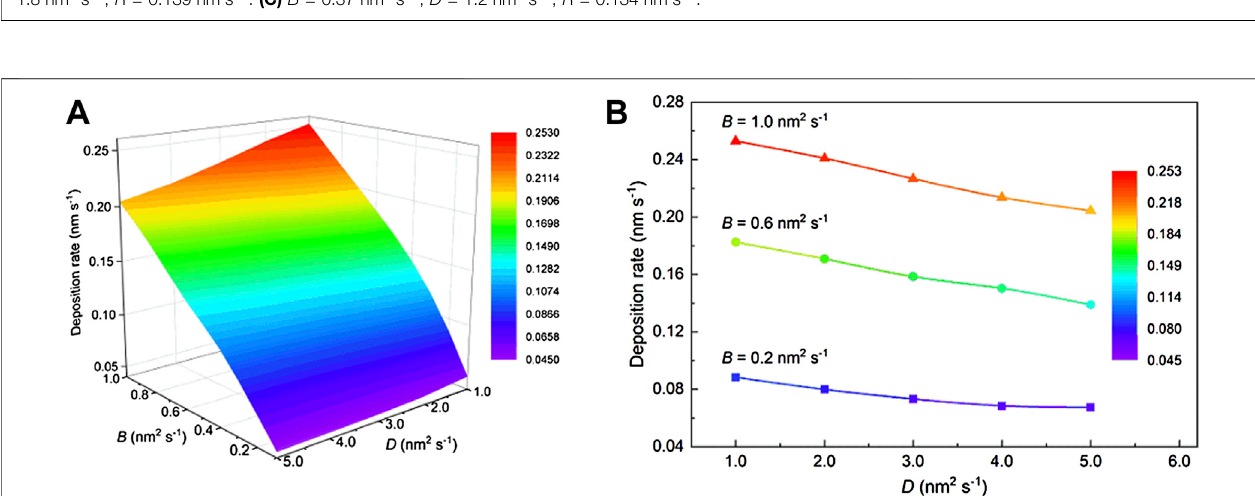
FIGURE3| Calculateddeposition rateofTiN coatings according tothephase- fi eld simulation results asafunction ofthevapor – solid transition velocity (i.e., B )and diffusion coef fi cient (i.e., D ): (A) 3D surface graph and (B) section pro fi les at the vapor – solid transition velocity (i.e., B ) of 0.2, 0.6, and 1.0 nm 2 s − 1 from the subgraph A .